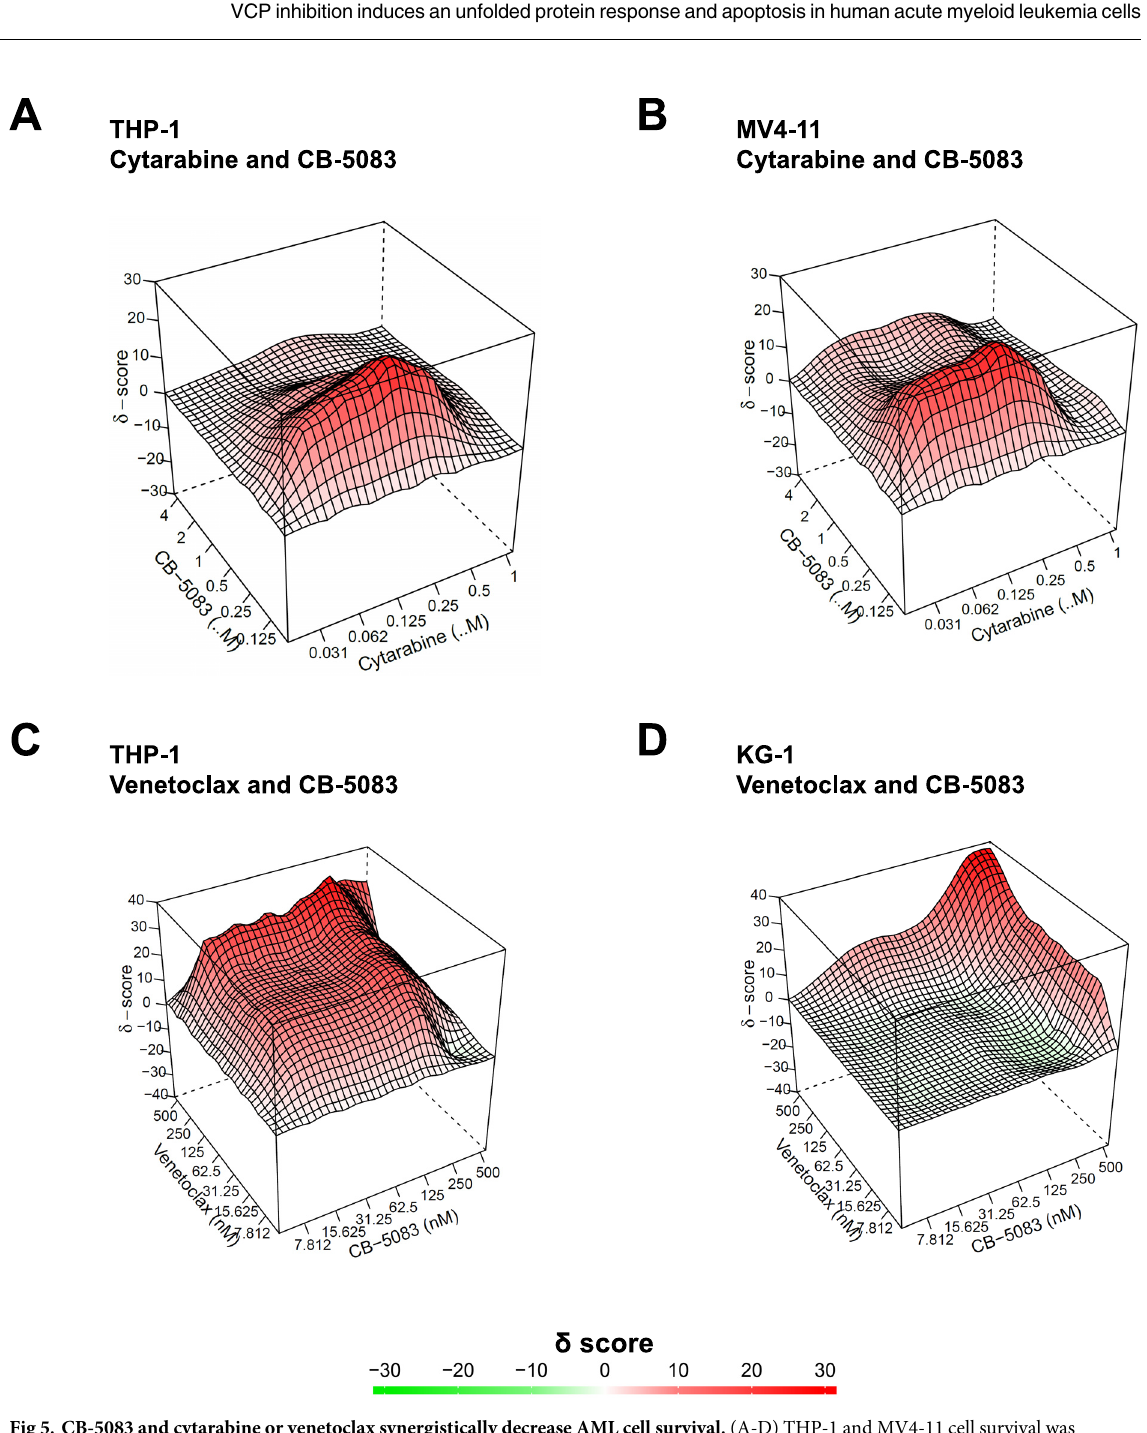
PLOS ONE | https://doi.org/10.1371/journal.pone.0266478 April 6,